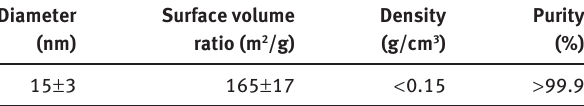
Table 3 . The abbreviations used in the study for labeling